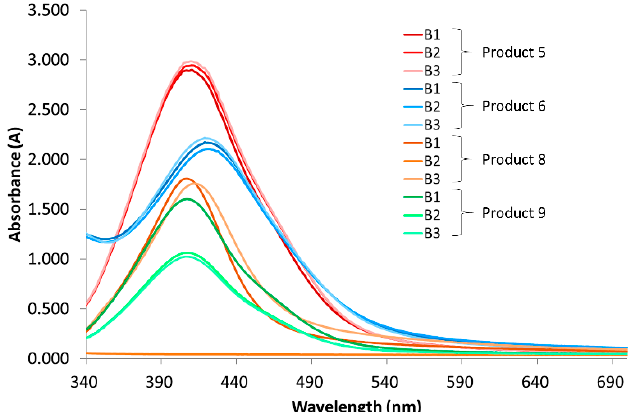
Figure 5. Absorbance spectra of the three different production batches of products 5, 6, 8, and 9. Products 5 and 6 were diluted with a 1:10 ratio and product 8 with a 1:2 ratio, and a 1:20 dilution of product 9 was measured. Batch 2 of product 8 was not diluted.